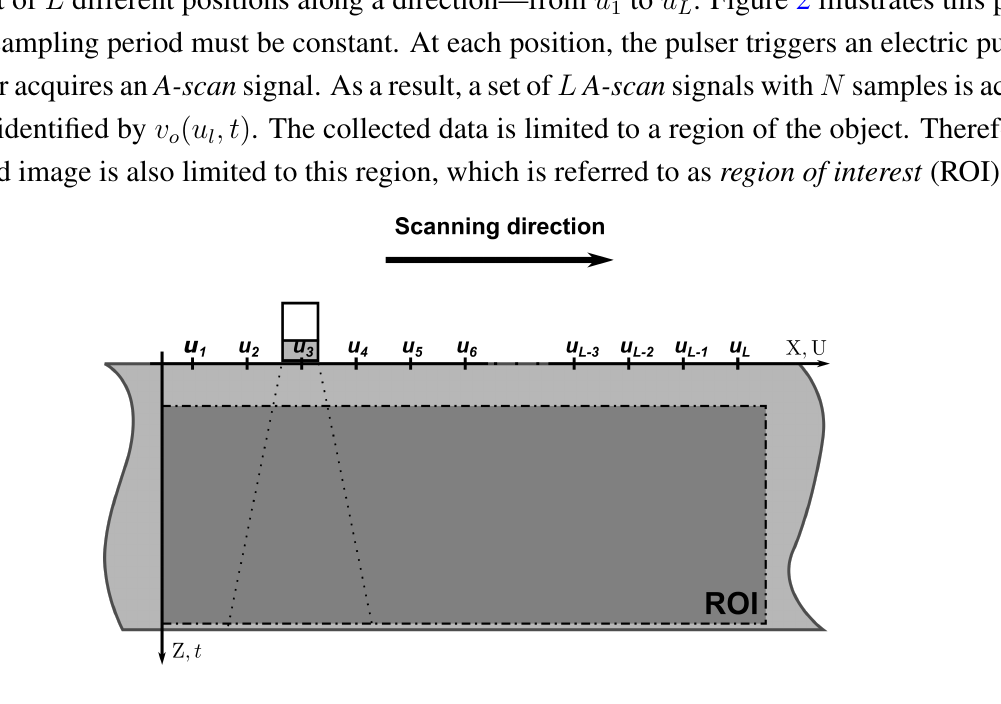
Figure 2. Example of a linear scan and the delimitation of the ROI in an object. The scanning direction is represented by the U axis, which coincides with the X axis of the object. The Z axis of the object—depth—is coincident with the t axis of the A-scan